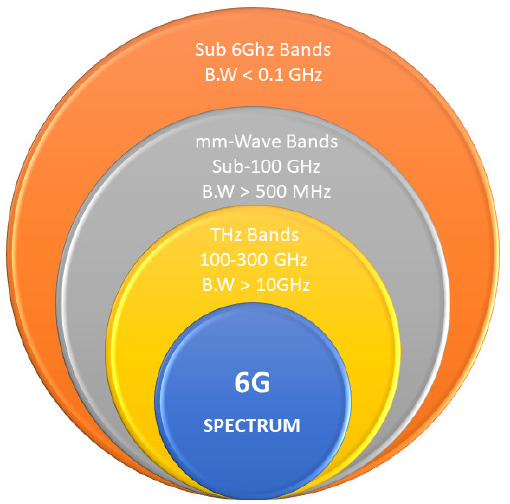
Figure 4. The frequency spectrum in 6G communication.